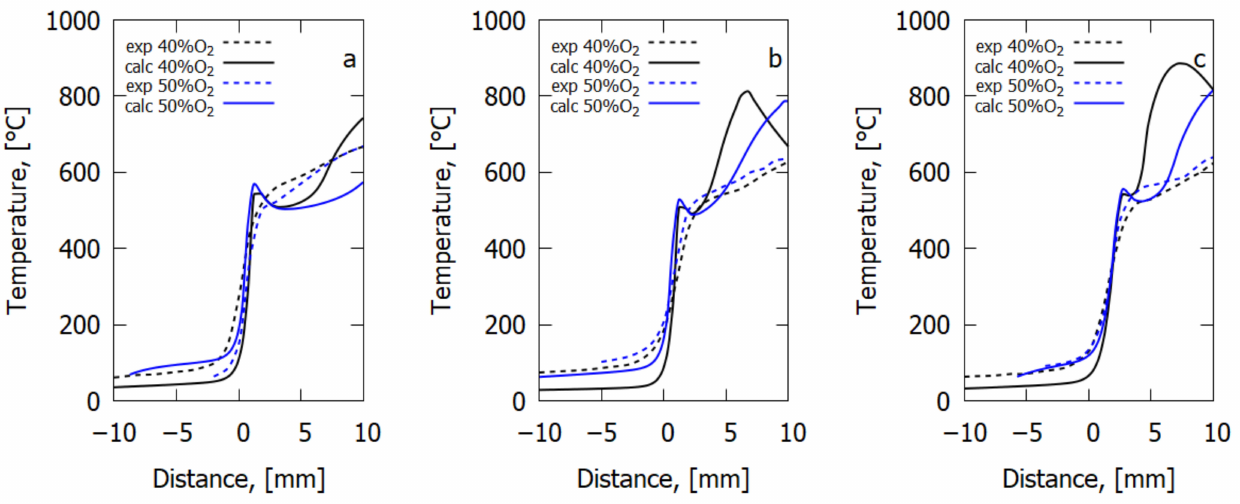
Figure 5. The temperature of the surface slabs ( a ) GFRER, ( b ) GFRER + 6% graphene, ( c ) GFRER + 6% DDM-DOPO. The experiment and the